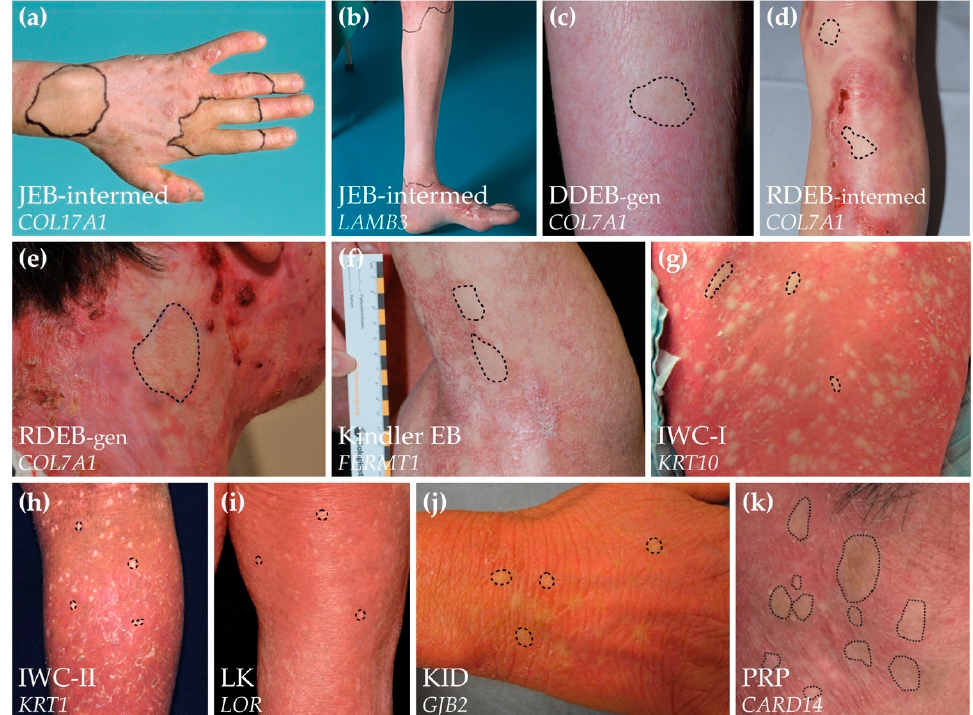
Figure 2. Overview of the revertant skin phenotypes in different genodermatoses. Revertant skin patches in ( a ) the COL17A1 -associated intermediate type of junctional epidermolysis bullosa (JEB- intermed) [75], ( b ) the LAMB3 -associated intermediate type of junctional epidermolysis bullosa (JEB-intermed) [74], ( c ) the generalized type of dominant dystrophic epidermolysis bullosa (DDEB- gen, COL7A1 ) [86], ( d ) the intermediate type of generalized recessive dystrophic epidermolysis bullosa (RDEB-intermed, COL7A1 ) [86], ( e ) the severe type of generalized recessive dystrophic epidermolysis bullosa (RDEB-gen, COL7A1 ) [68], ( f ) Kindler epidermolysis bullosa (Kindler EB, FERMT1 ) [70], ( g ) ichthyosis with confetti type 1 (IWC-I, KRT10 ) [81], ( h ) ichthyosis with confetti type 2 (IWC-II, KRT1 ) [87], ( i ) loricrin keratoderma (LK, LOR ) [83], ( j ) keratitis-ichthyosis-deafness syndrome (KID, GJB2 ), and ( k ) pityriasis rubra pilaris (PRP, CARD14 ) [84]. Solid or dashed lines indicate revertant patches amidst affected skin (note that on several panels more revertant patches are visible than highlighted). Note that the revertant patches in the different types of recessive EB are generally larger than in the autosomal dominant ichthyotic disorders, whereas multiple revertant spots are usually identified simultaneously in the latter. All images re-used with permission and the original articles are cited.